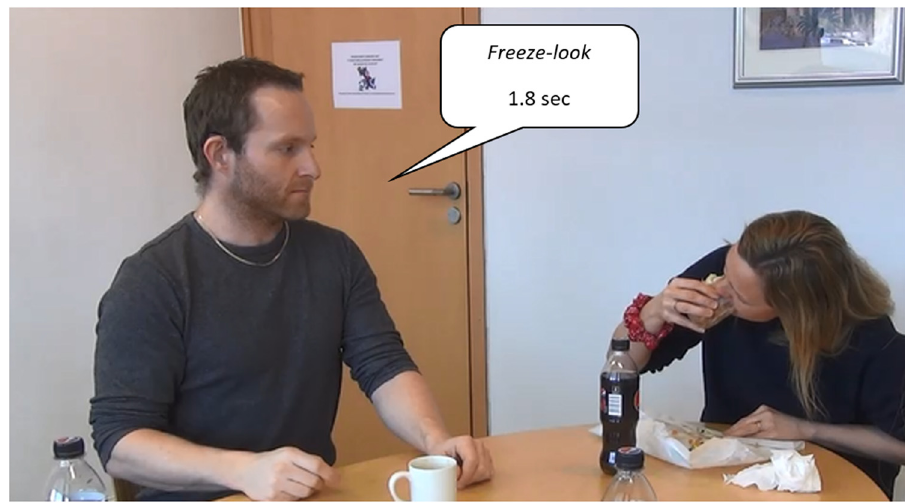
Figure 1: Adam doing a freeze - look response. ( Line 2 in the transcription.